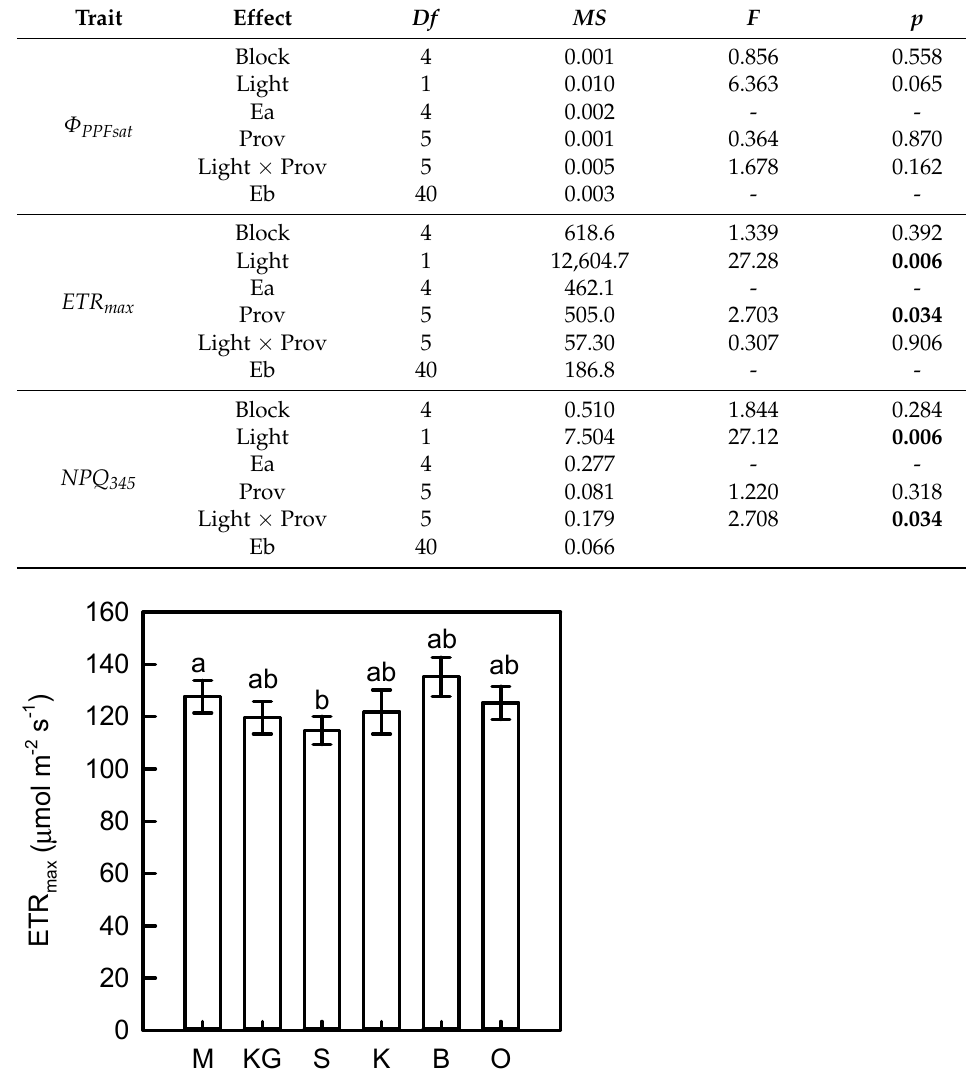
Table 5. The split-plot analysis of variance for the effects of blocks (replications), irradiance level (40% or 100% of full solar irradiance), and provenance of Abies alba seedlings on photochemical parameters: quantum yield of PSII photochemistry at saturating PPF ( Φ PPFsat ), maximal apparent electron transfer rate ( ETR max ), and non-photochemical quenching of fluorescence at PPF = 345 µ mol m − 2 s − 1 ( NPQ 345 ). The values of probability in bold indicate significant differences between means ( p < 0.05).